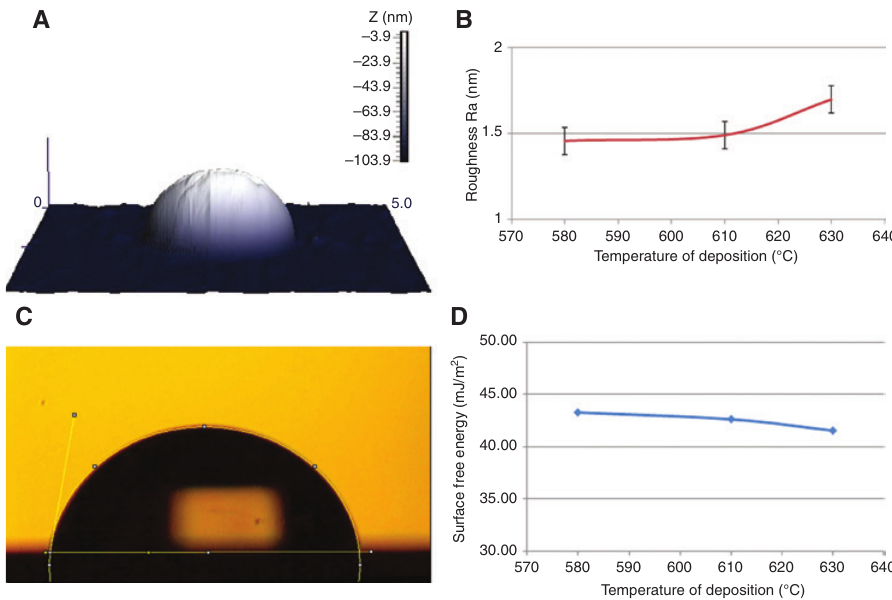
Figure 7: Example of the measurement results. (A) Cantilever tip surface. (B) Roughness of the polysilicon samples. (C) Example of a water droplet on a polysilicon sample. (D) Surface free energy of polysilicon